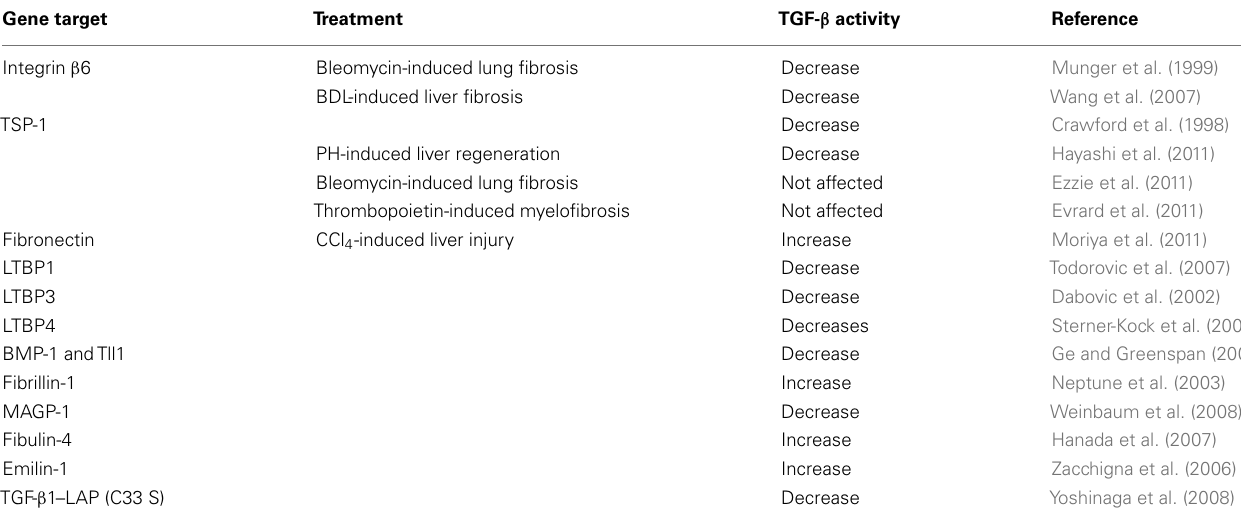
Table 1 |AlteredTGF- β activity in knockout or mutant